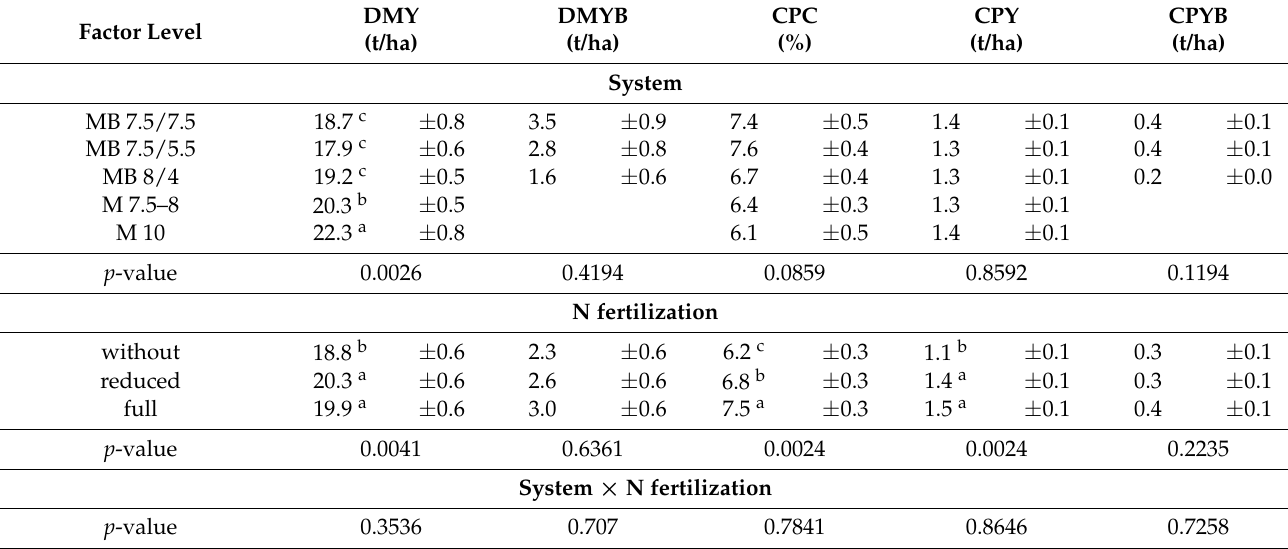
Table 4. Results for all yield-related dependent